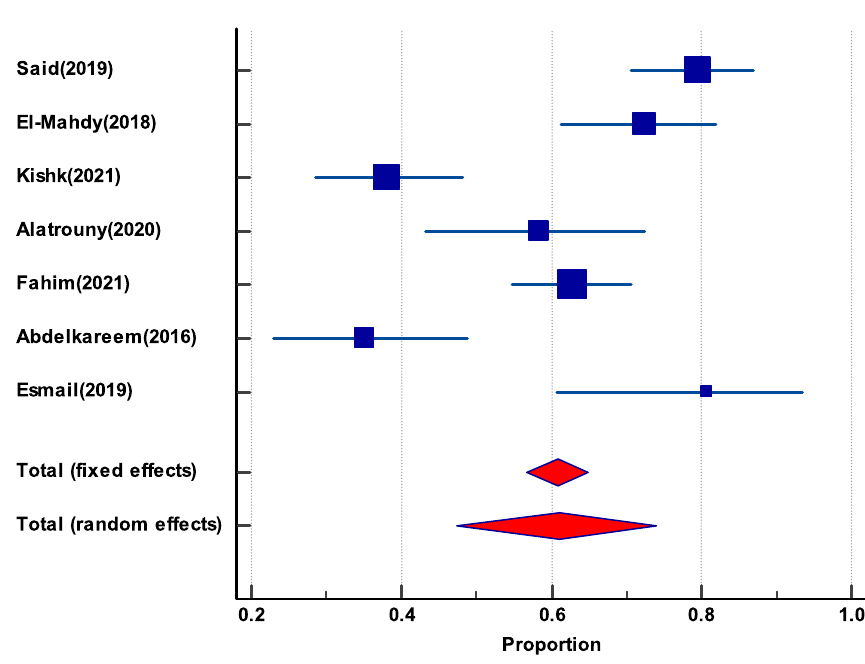
Fig. 9 Forest plot of enterococci isolates resistant to high-level gentamicin